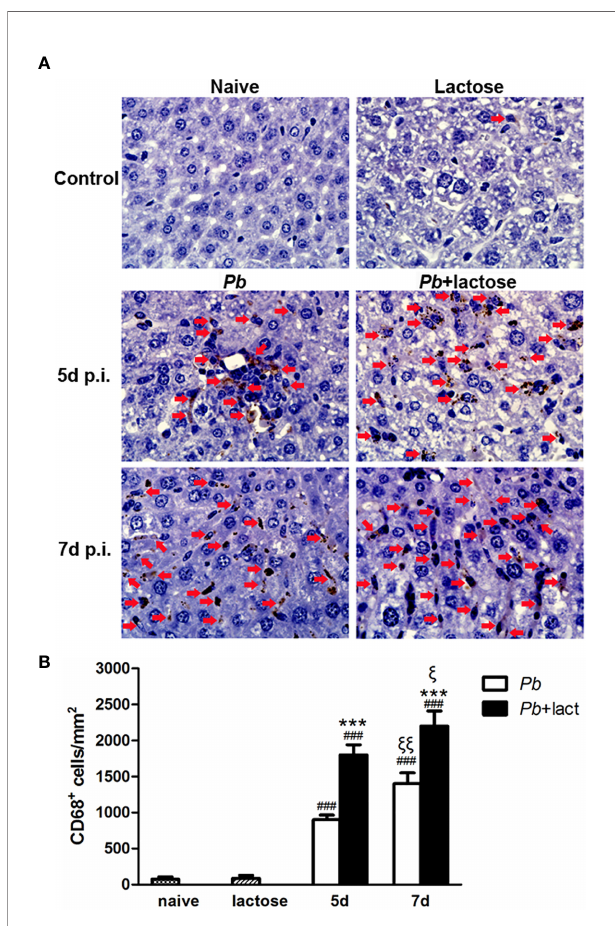
FIGURE 4 | Immunohistochemical staining for CD68 + macrophages inthe livers of Pb ANKA-infectedmice with or without a -lactose treatment. (A) Immunohistochemical staining of CD68 + macrophages in the liversof uninfected mice, uninfected mice with a -lactose treatment, malarial mice, andmalarial mice with a -lactose treatment on day 7 p.i.Positive cells were indicated with red arrow heads. Originalmagni fi cation × 1,000. (B) Morphometricanalysisofliver tissues. Shownare CD68 + macrophages per square millimeter.Dataare presented as means± SD; experiments were performed with three mice per group. ### P < 0.001, malarial mice on day 5 p.i., malarialmice with a -lactose treatment on day 5 p.i., malarial mice on day 7 p.i., and malarial mice with a -lactose treatment onday 7 p.i. vs . naive group;*** P < 0.001, malarial mice with a -lactose treatment onday 5 p.i. vs . malarial mice on day 5 p.i.; *** P < 0.001, malarial mice with a -lactose treatment onday 7 p.i. vs . malarial mice on day 7 p.i.; x P < 0.05, malarial mice with a -lactose treatment on day 7 p.i. vs . malarialmice with a -lactose treatment on day 5 p.i.; xx P < 0.01, malarial mice on day 7 p.i. vs . malarialmiceonday 5